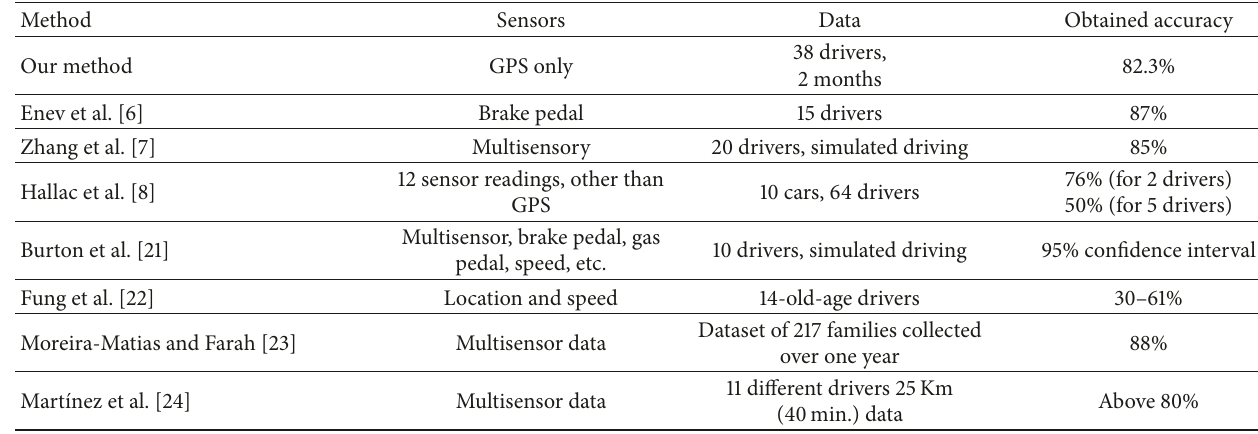
Table 12: Comparison of the proposed method with other existing